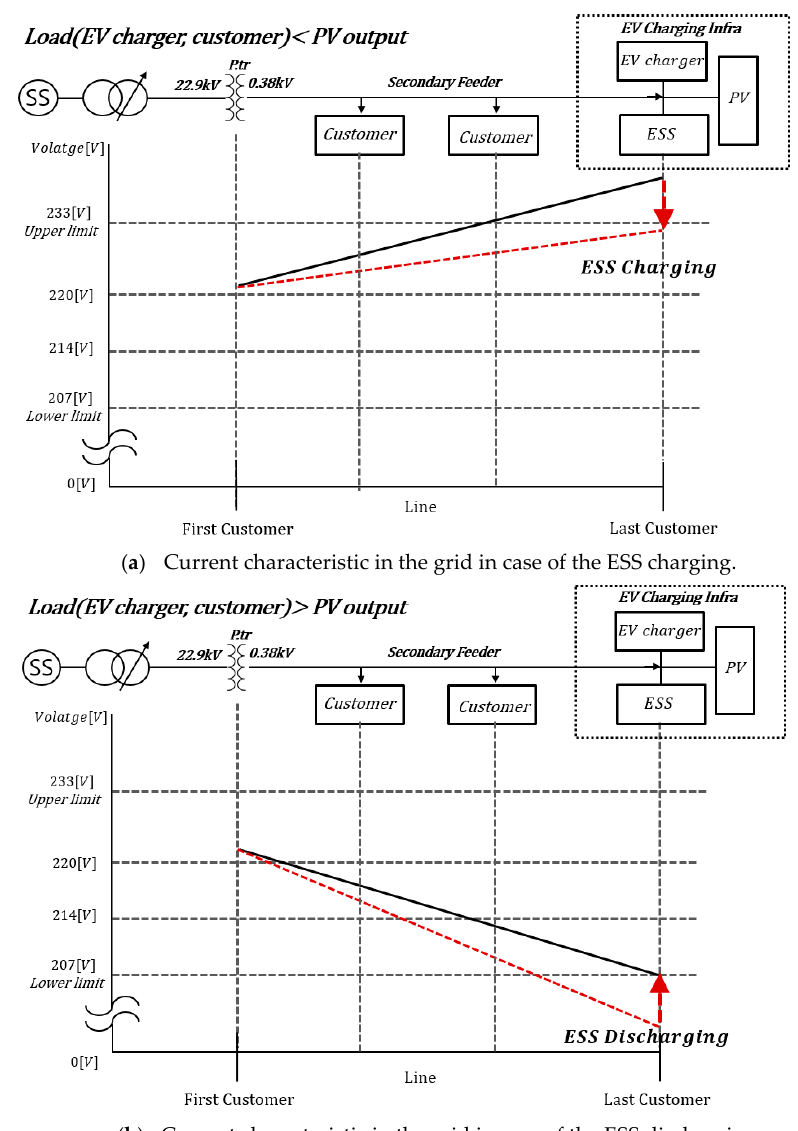
Figure 2. Current characteristics in the grid according to the ESS operation.